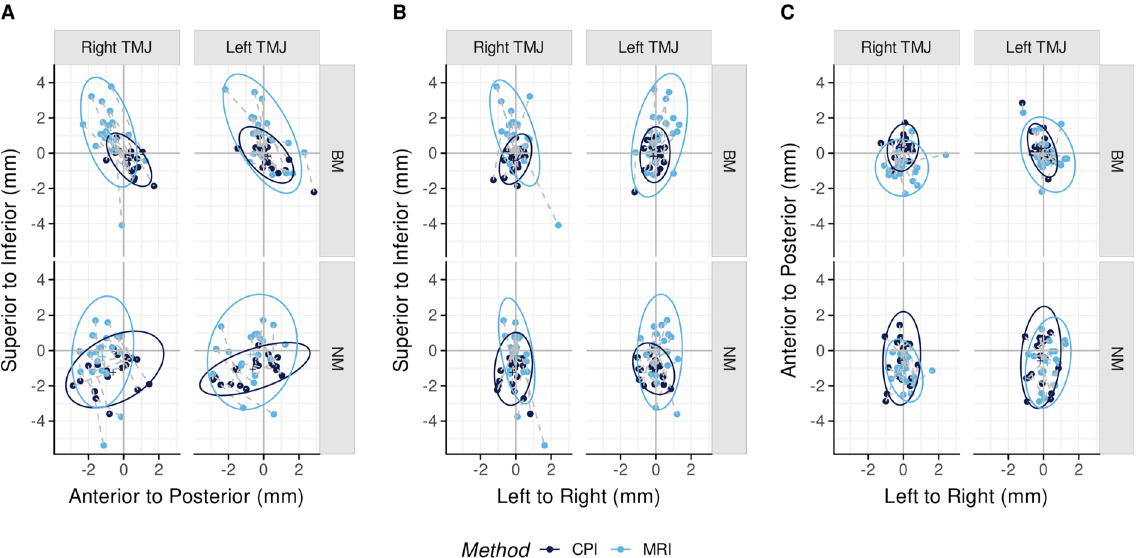
Figure 4. 95% data ellipses. CPI data in dark blue, MRI data in light blue. Bimanual manipulation (BM) and neuromuscular position (NM) condylar positions are shown in the sagittal plane ( A ), frontal plane ( B ), and horizontal plane ( C ). Crosses indicate means, dashed lines connect corresponding CPI-MRI condylar positions of